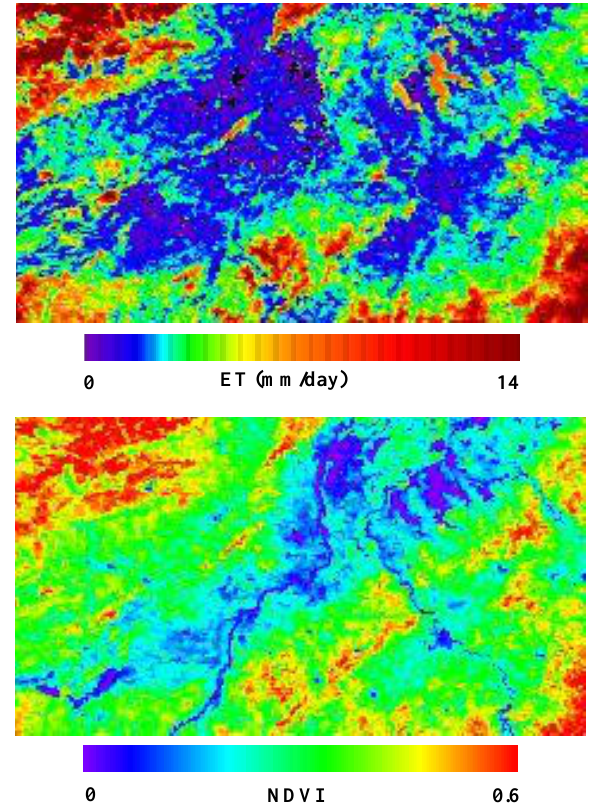
Fig. 7. Spatial distribution of daily ET (top) and NDVI (bottom) maps at 1km resolution for 3 January 2008 over the study area.